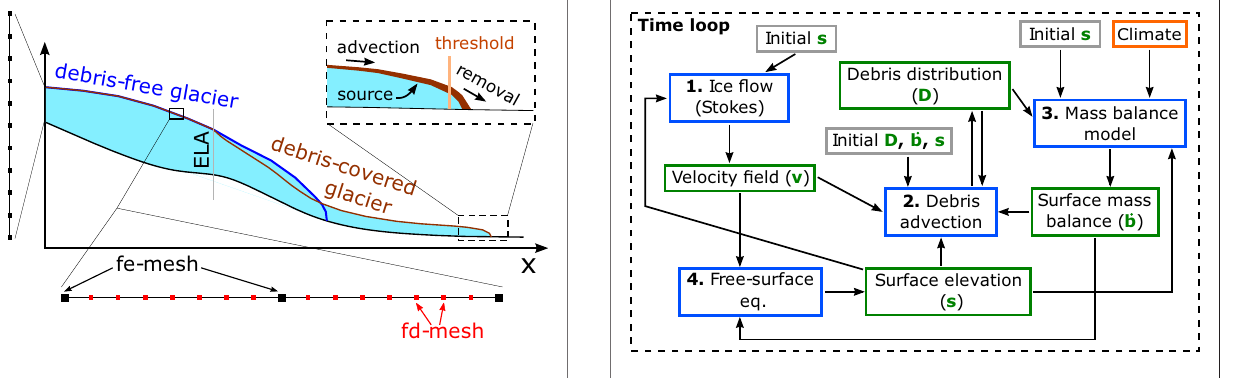
FIGURE 2 | Ice/debris glacier system as implemented in our modelling approach. The bedrock geometry is pre-de fi ned, while glacier evolution is determined by external forcing. Debris emerges below the ELA in consequence of ice melt and is advected down-valley. Different mechanisms determine the fate of terminal debris. Ice dynamics is calculated on an fe-mesh (black squares), whereas debris advection requires a fi ner fd- mesh (red squares).